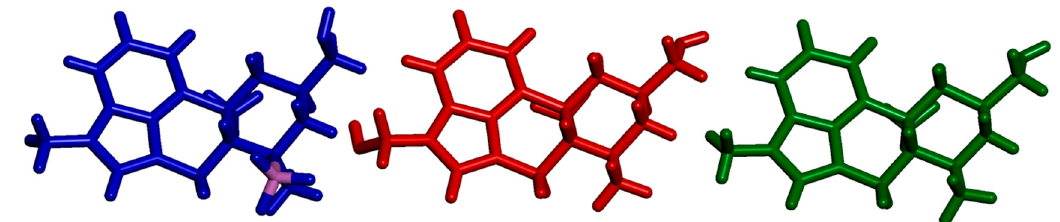
Figure 4. Parallel-oriented molecules of Luol derivatives. BH 3 -MeLuol ( 4 )—blue, Luol ( 5 )—red, MeLuol ( 3 )—green, boron—pink.